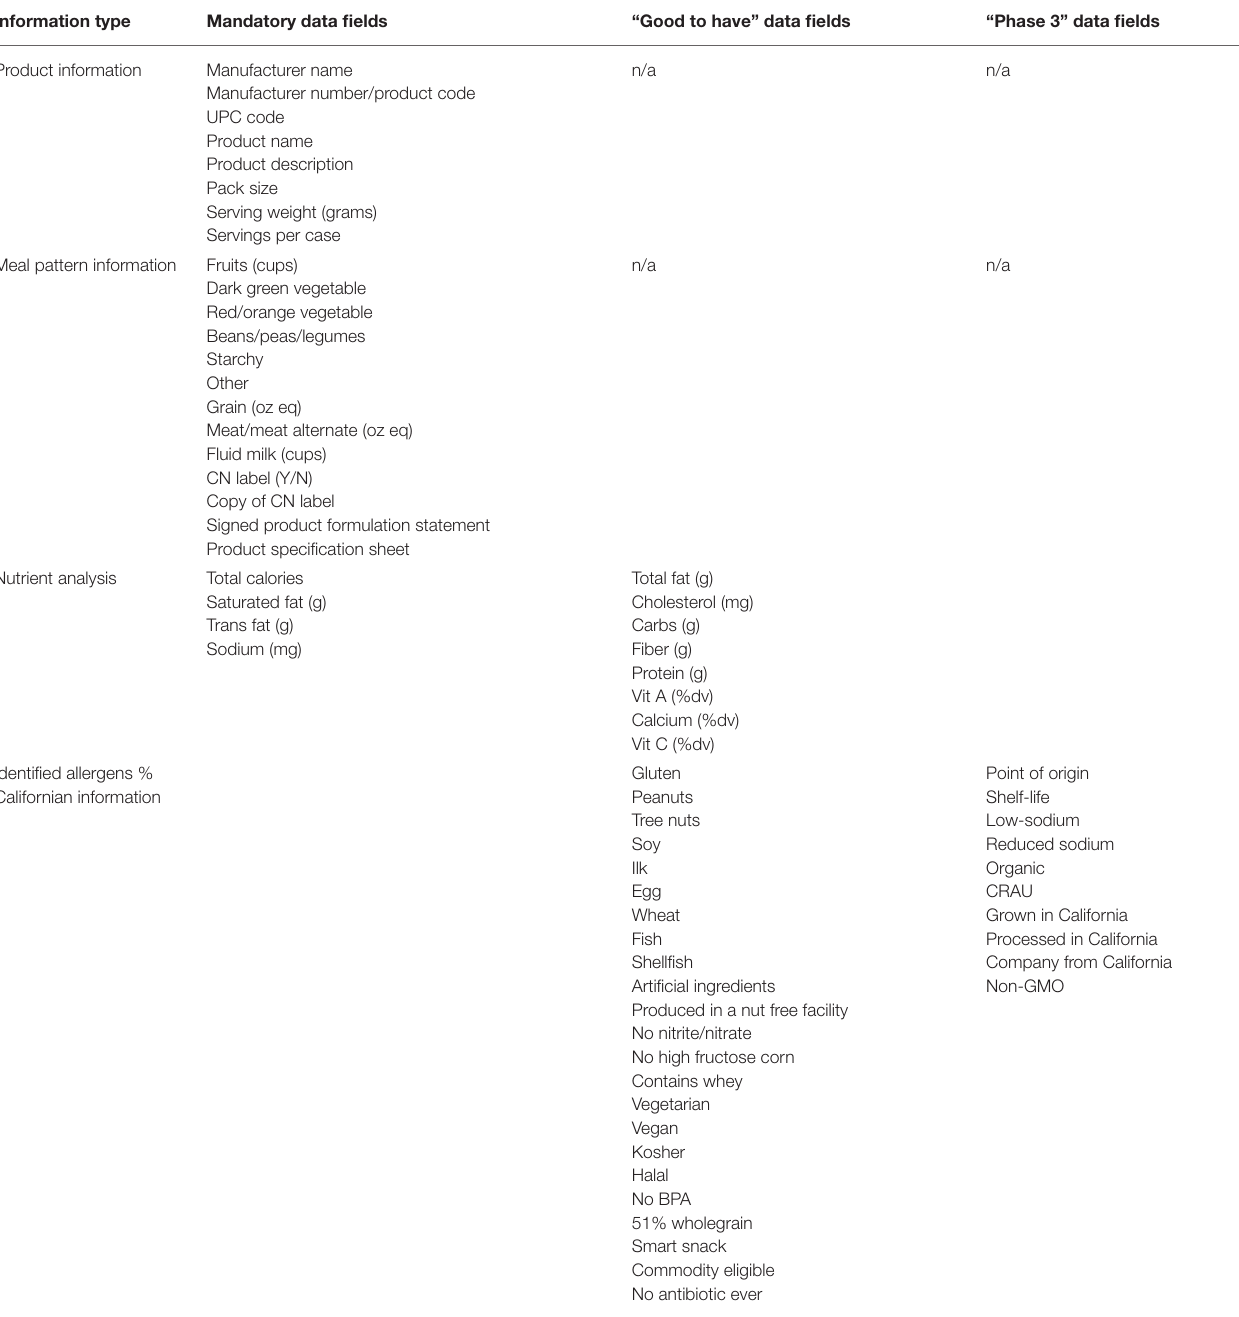
TABLE 1 | Detailed data fields earmarked for automated extraction in the initial project specifications documents. Source: (Project Documentation, 2020). Information